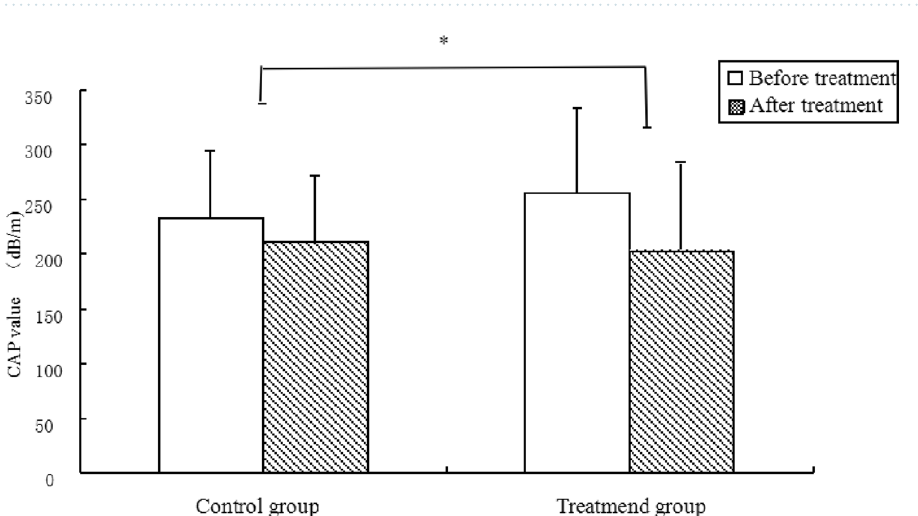
Figure 3. The treatment group presented a more robust decrease in CAP values than the control group. * p < 0.05; CAP controlled attenuation